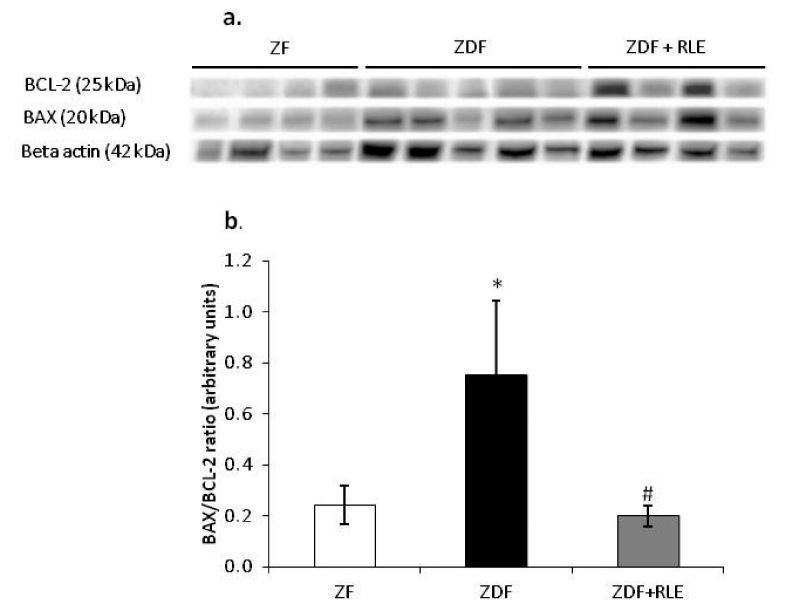
Figure 5. E ff ect of red orange and lemon extract (RLE) on the protein levels of the BAX / BCL-2 ratio in the Zucker Fatty (ZF) ( n = 4), the Zucker Diabetic Fatty (ZDF) ( n = 5), and the Zucker Diabetic Fatty + red orange and lemon extract (ZDF + RLE) ( n = 4), after 24 weeks of treatment. ( a ) Representative western blot of BAX and BCL-2 in ZF, ZDF, and the ZDF-treated group; ( b ) densitometric analysis of the BAX / BCL-2 ratio. Experiments were conducted in triplicates, and the values were normalized towards the tubuline. Data are shown as mean ± standard deviation (DS) and were compared by ANOVA (* p < 0.05 versus ZF, # p < 0.05 versus ZDF).